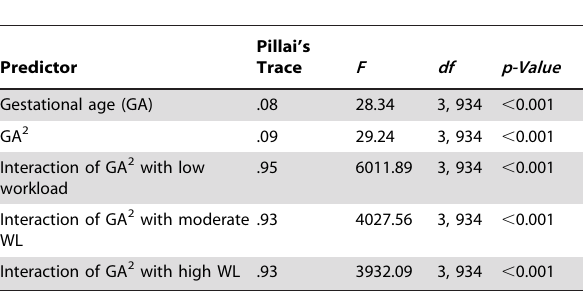
Table 3. Multivariate analysis of variance ( MANOVA ) testing the effects of gestational age on children’s performance in low, moderate, and high cognitive workload tasks ( n =